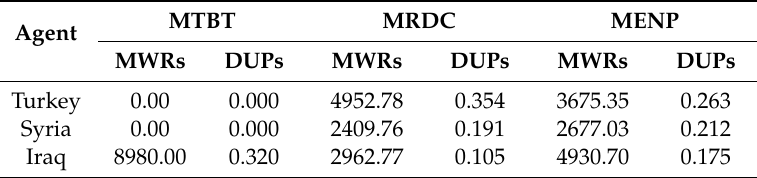
Table 4. Minimum water rights (MWRs) and disagreement utility points (DUPs) for the three countries in the Euphrates River Basin under three methods. MTBT: method for defining agents’ MWRs based on traditional bankruptcy theory. MRDC: method for defining agents’ MWRs based on PRO division with respect to their rates of demand and contribution. MENP: method for defining agents’ MWRs based on PRO division with respect to their external NPs. MTBT MRDC MENP Agent MWRs DUPs MWRs DUPs MWRs